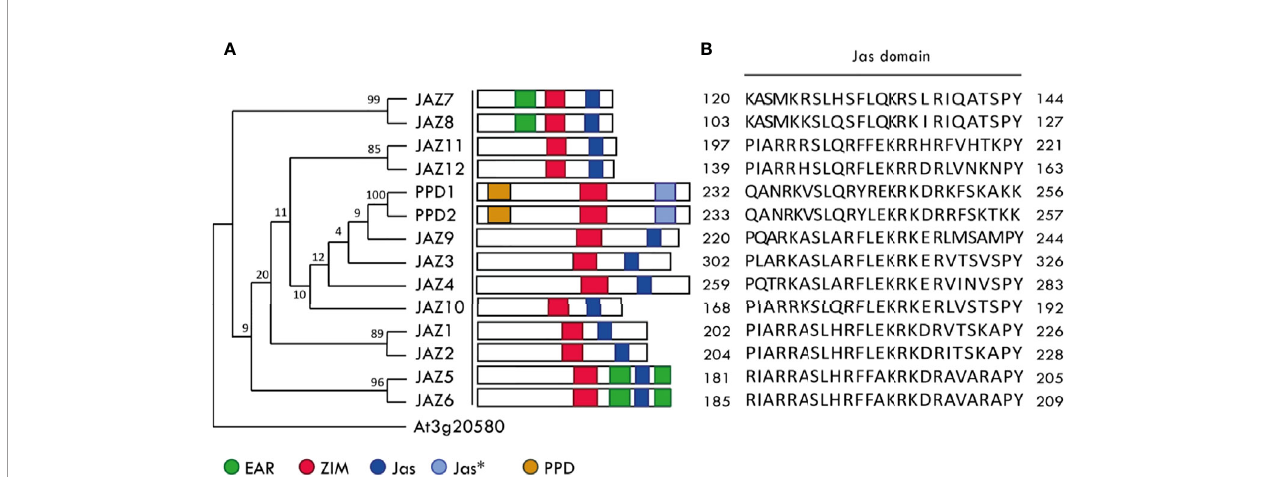
FIGURE 1 | Class II TIFY protein family in Arabidopsis. (A) Phylogenetic tree of class II TIFY protein family in Arabidopsis. The tree was constructed using the complete amino acid sequence alignment using the maximum parsimony method (MEGA7: Molecular Evolutionary Genetics Analysis version 7.0). At3g20580 was chosen as the outgroup (Vanholme et al., 2007). The numbers above the branches are bootstrap values from 500 replicates. Graphical representations of ZIM, Jas, EAR, and PPD domains are given and were adapted from (Cue ́ llar Pe ́ rez et al., 2014). Jas* indicates the Jas-like domain. (B) Jas domain sequences from the class II TIFY protein